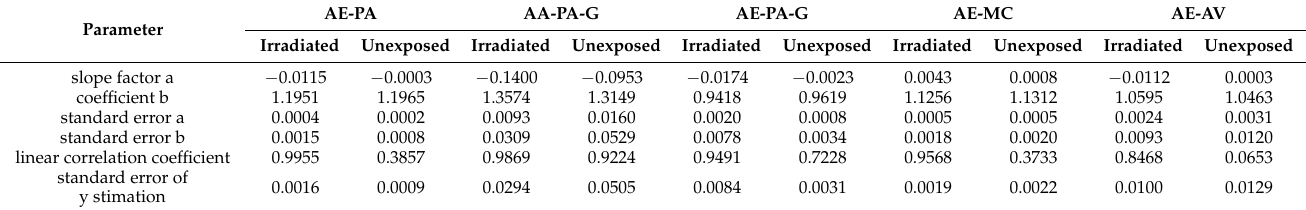
Table 4. Linear correlation parameters for the obtained data.